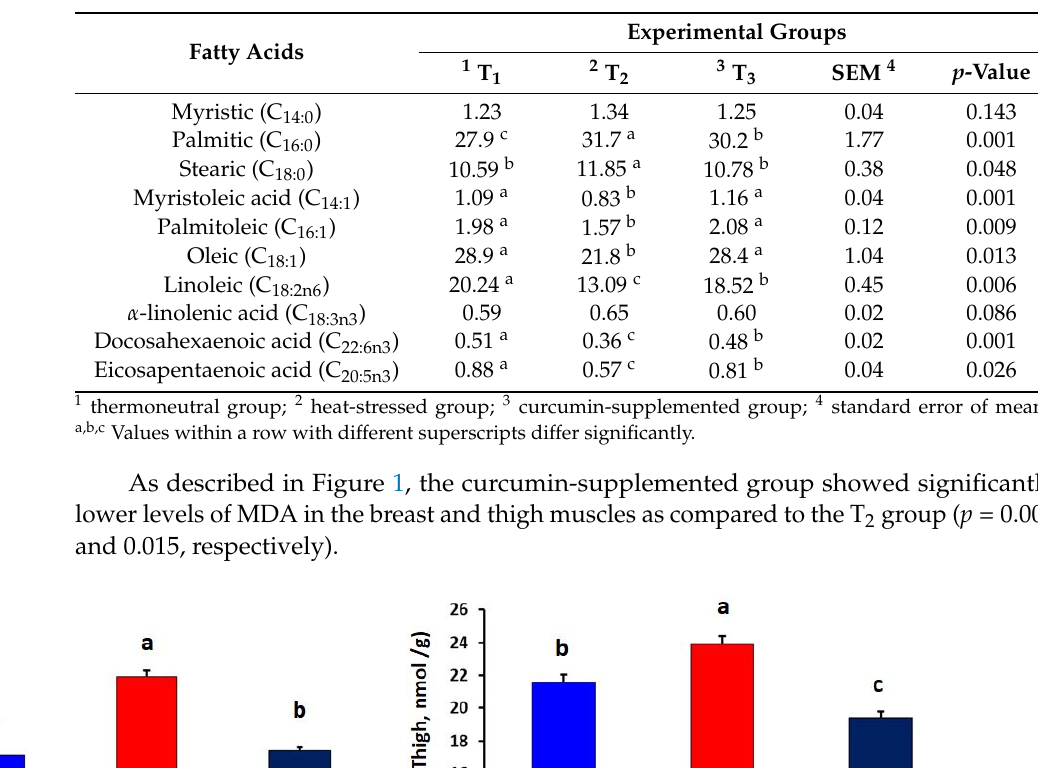
Figure 2. Effect of dietary curcumin supplementation on the levels of adenosine triphosphate (ATP) and adenosine diphosphate (ADP) in liver tissues of heat-stressed broiler chickens ( p = 0.001 and 0.011, respectively). Meanwhile, the heat-stressed (T 2 ) group showed significantly higher levels of ADP and Na,K-ATPase in the liver tissues than that of the other experimental groups ( p = 0.011 and 0.027, respectively). The dietary curcumin supplementation significantly ( p = 0.012) increased the CoQ10 level in liver tissues as compared to other experimental groups (Fig- ure 3). Compared to the heat-stressed group, the T 1 and T 2 groups showed significantly higher serotonin in brain tissues of broiler chickens ( p = 0.006). However, the level of 5- hydroxyindoleacetic acid in brain tissues did not differ among the experimental groups (Figure 4).